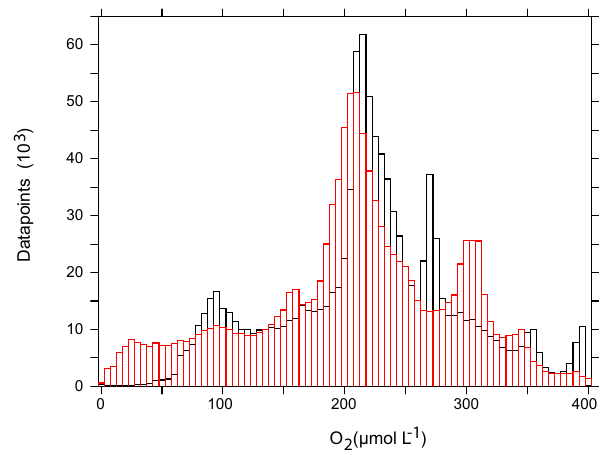
Figure 8. Distribution of O 2 concentration in the NEMO-PISCES 1985 to 2005 averaged time period (black) compared to the oxygen- corrected World Ocean Atlas (red) from Bianchi et al. (2012). Inter- val widths are O 2 concentrations at steps of 5µmolL − 1 .